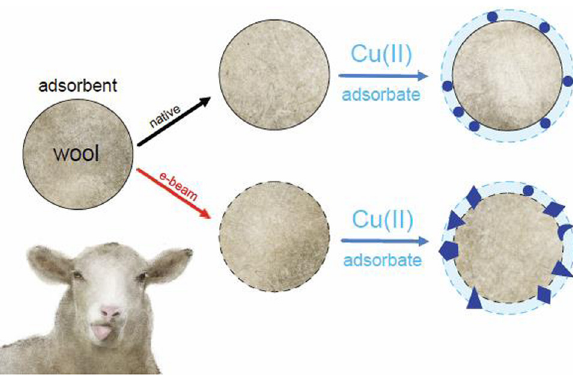
Figure 4: Concept of mixed Cu ( II ) adsorption on electron irradiated sheep wool with the wool surface occupied with various Cu - com - plexes ( chemisorption ) along a minor contribution